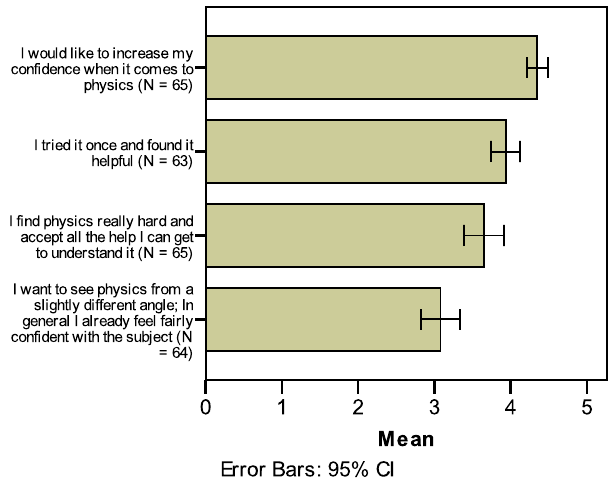
FIG. 6. (cid:1) Color online (cid:2) Student response to the statement “I come to map meetings because … .